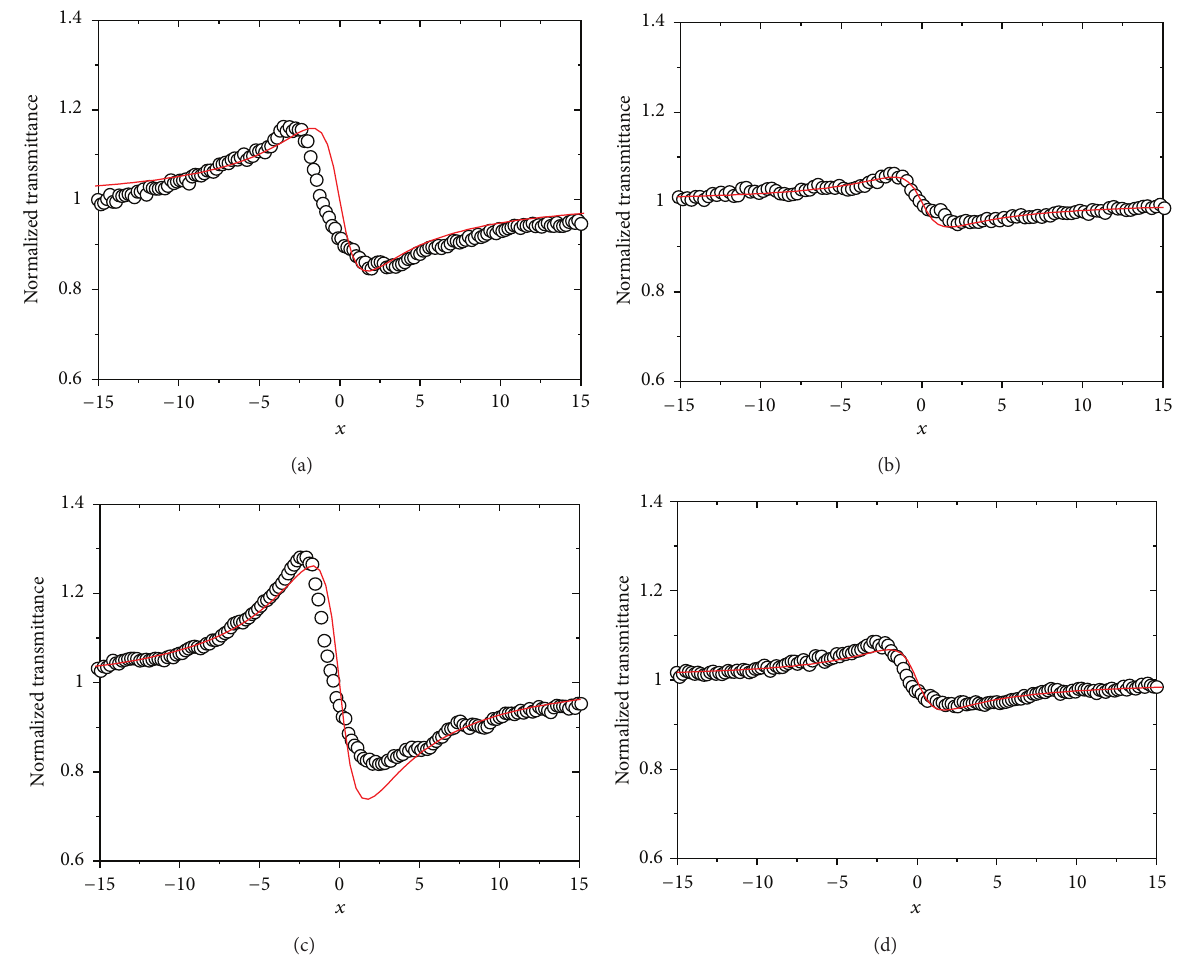
= 9.24 mW, (b) HMI + with 𝑃 = 9.01 mW, LASER LASER = 8.65 mW. The minimum beam waist was 𝑤 = 18𝜇 m and the aperture 0 LASER